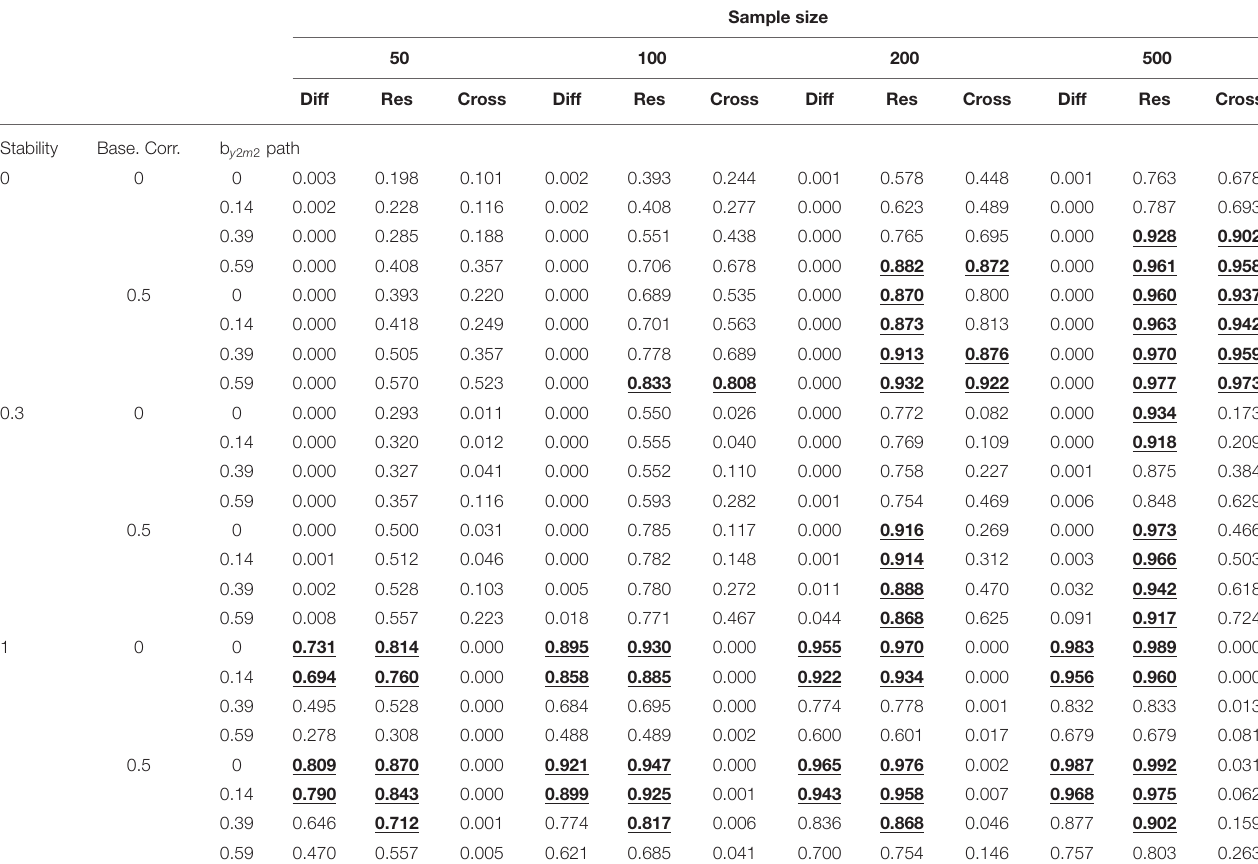
TABLE 2 | T -size CFI values (CFI_t) for the difference score model (Diff), residualized change score model (Res), and cross-sectional model (Cross) for M 2 cross-lag = 0 and Y 2 cross-lag =